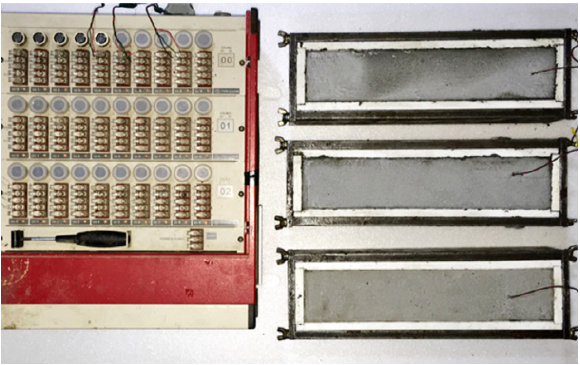
Figure 2. Test setup for measuring drying shrinkage and specimens cast in molds.